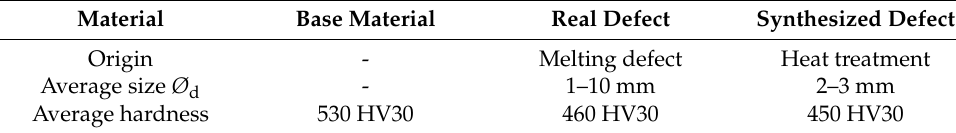
Table 3. Characteristics of the material